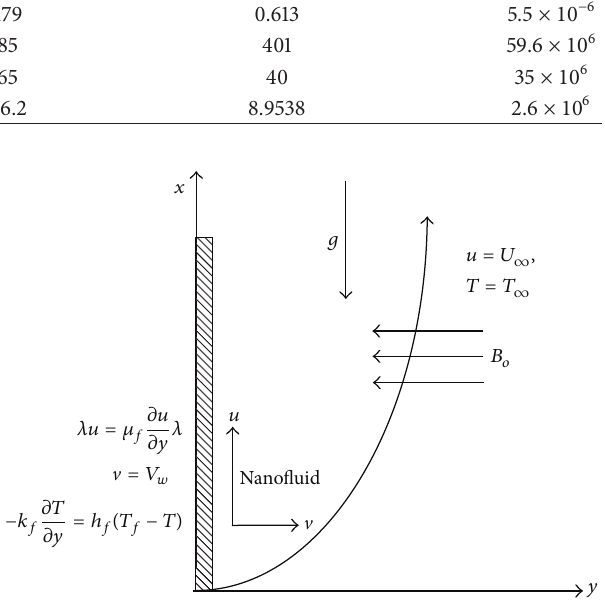
Figure 1: Flow configuration and coordinate